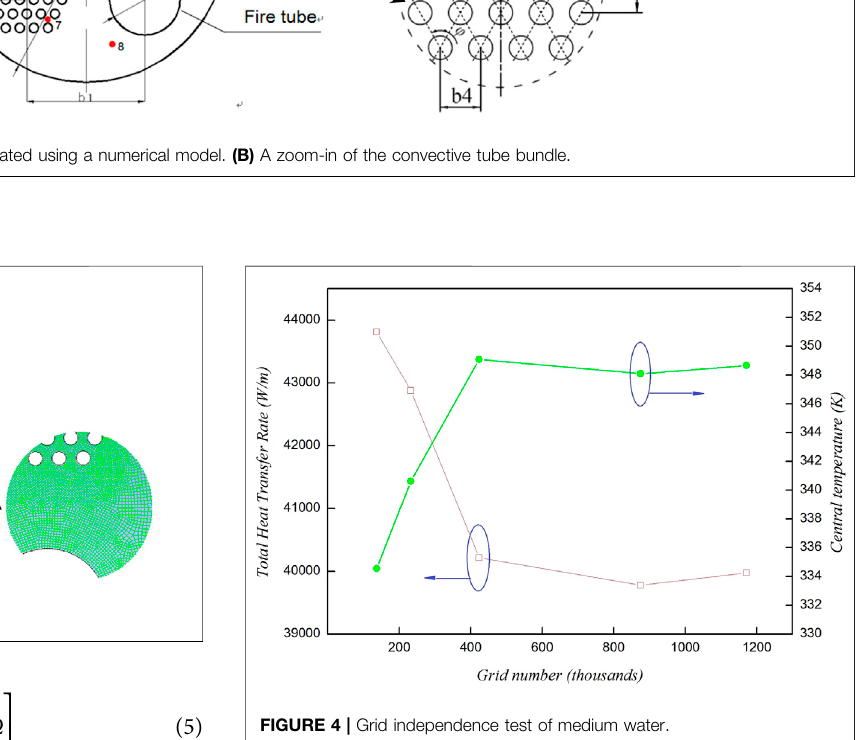
FIGURE 4 | Grid independence test of medium water.